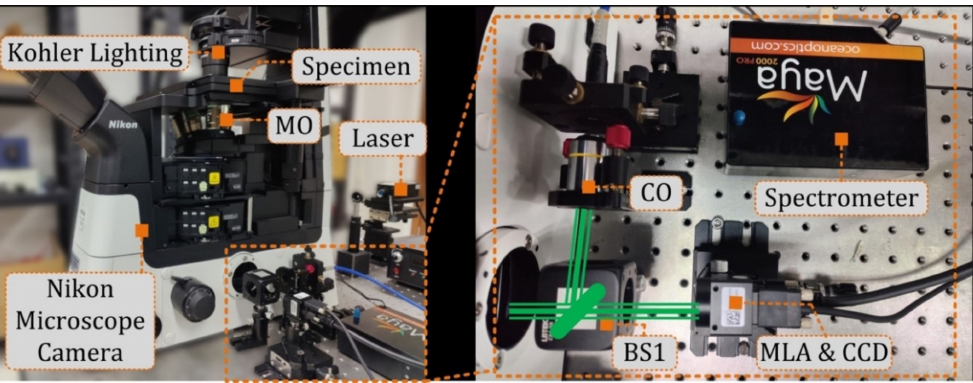
Figure 5. The Autostereoscopy-Raman Spectrometry-based measurement